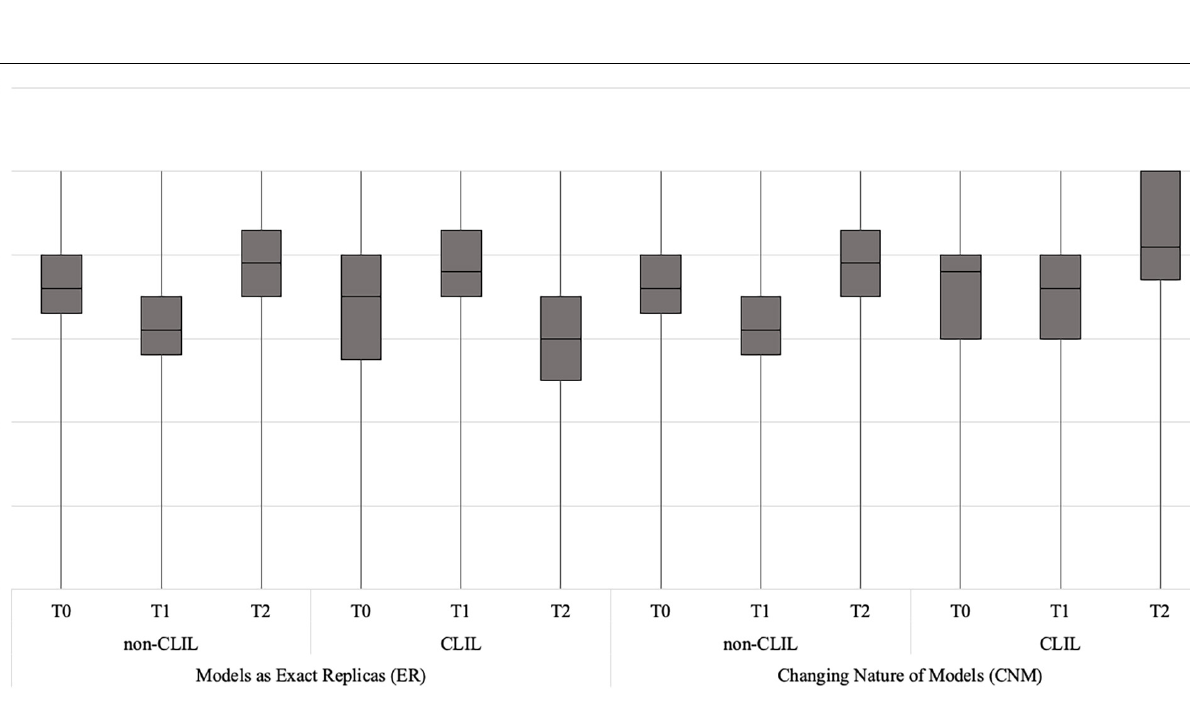
Frontiers in Education |